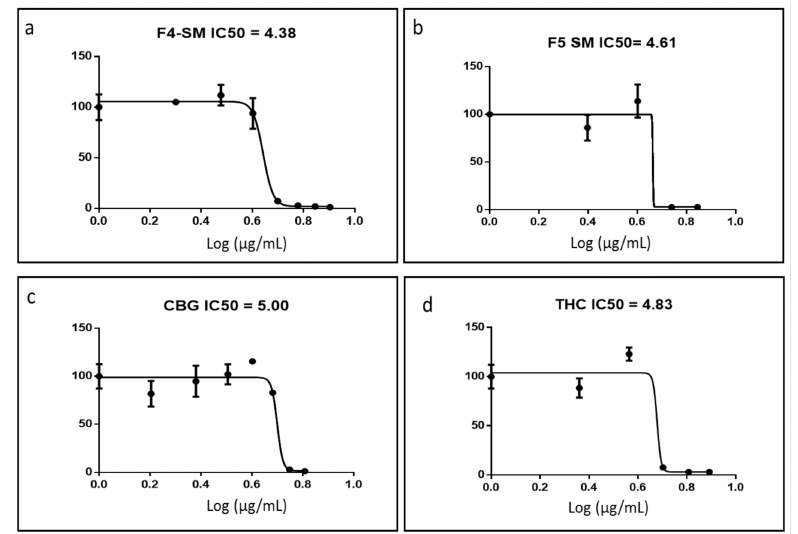
Figure 2. Cell viability of A172 cells following treatment with F4-SM ( a ), F5-SM ( b ), CBG ( c ), and THC ( d ) at different concentrations for 48 h. Cell viability was determined by XTT assay as a function of live cell number. The IC50 values were calculated from 5P logistic curve fit by GraphPad Prism version 6.1. Error bars indicate ± SE ( n =